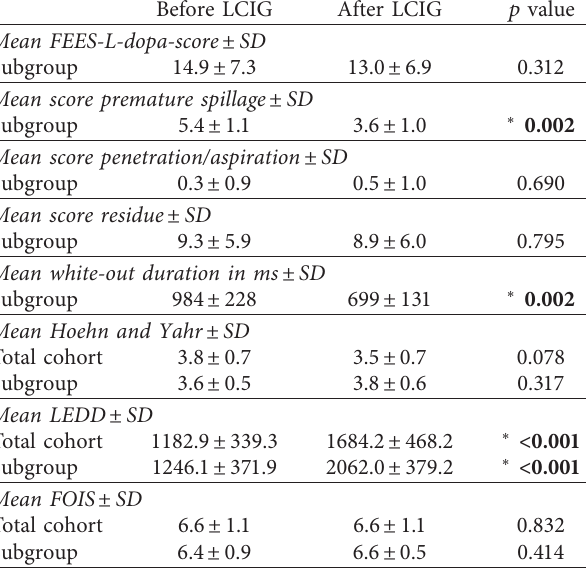
Table 2: Descriptive statistics of the FEES-L-dopa-score and its subdomains, white-out duration, levodopa equivalent daily dose (LEDD), Hoehn and Yahr scale, and functional oral intake scale (FOIS), as well as the p value of the comparison before and after beginning of levodopa-carbidopa intestinal gel (LCIG) in the total cohort and the subgroup of patients with follow-up FEES before and after beginning with